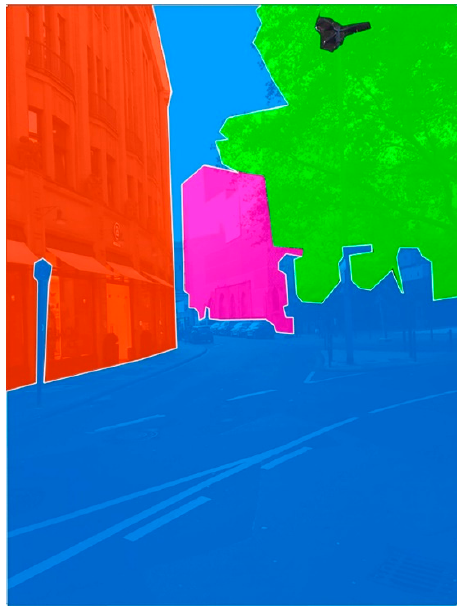
Figure 3. Areas of interest (AOI) and the unclassified area outlined for image 1, legend: area 1AOI1—pink, area 1AOI2—red, area 1AOI3—green, area Not on 1AOI—blue. Table 1. Parameters describing the process of the observation of areas outlined on image 1. Item